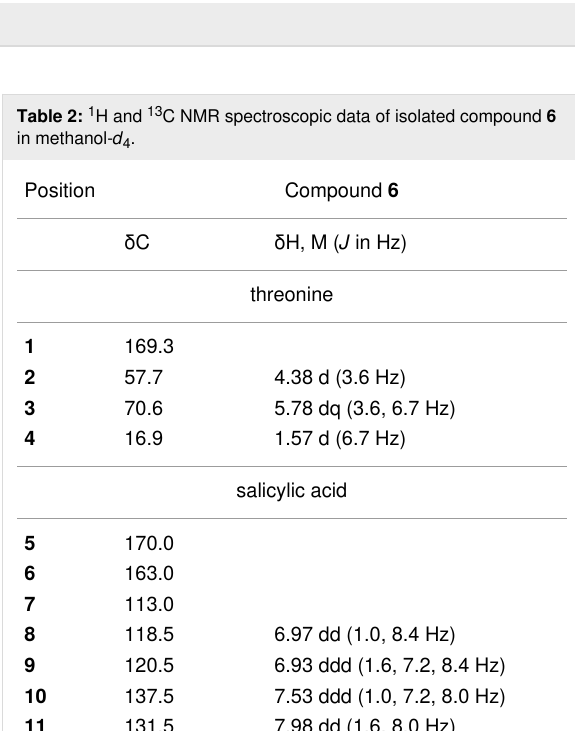
Figure 3: MS–MS fragmentation of amamistatins ( 1 – 5 ).